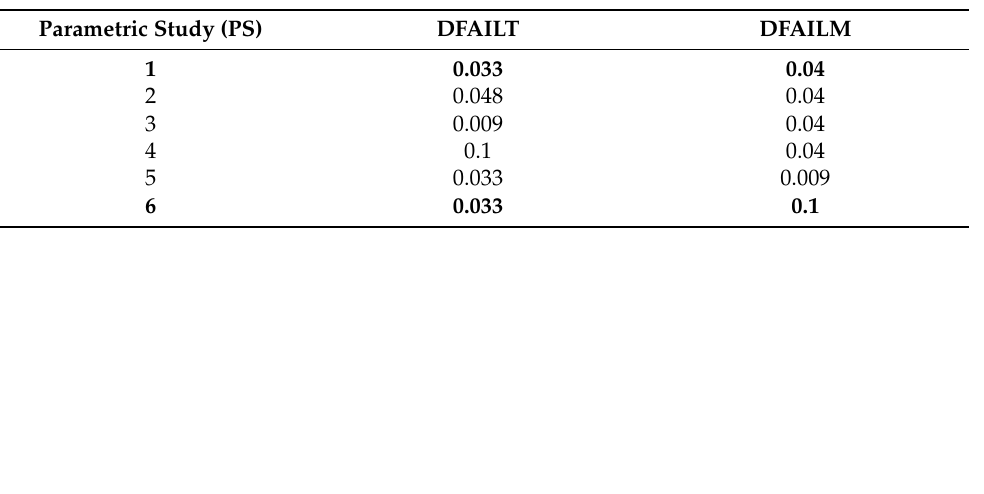
Figure 9. Theoretical and numerical strains for the parametric study.